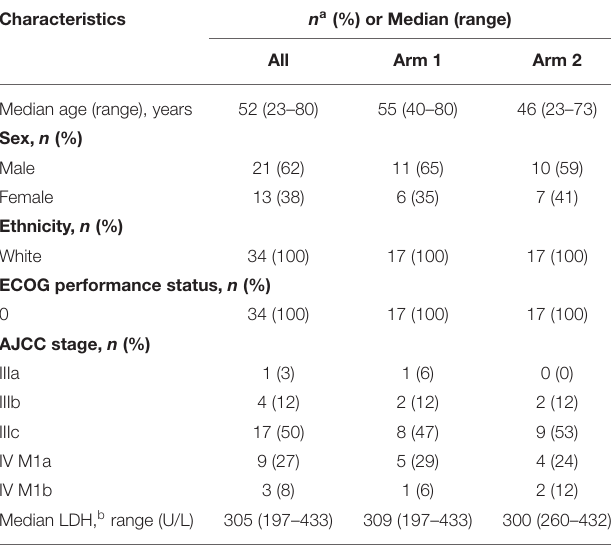
TABLE 1 | Patient demographic and baseline characteristics.